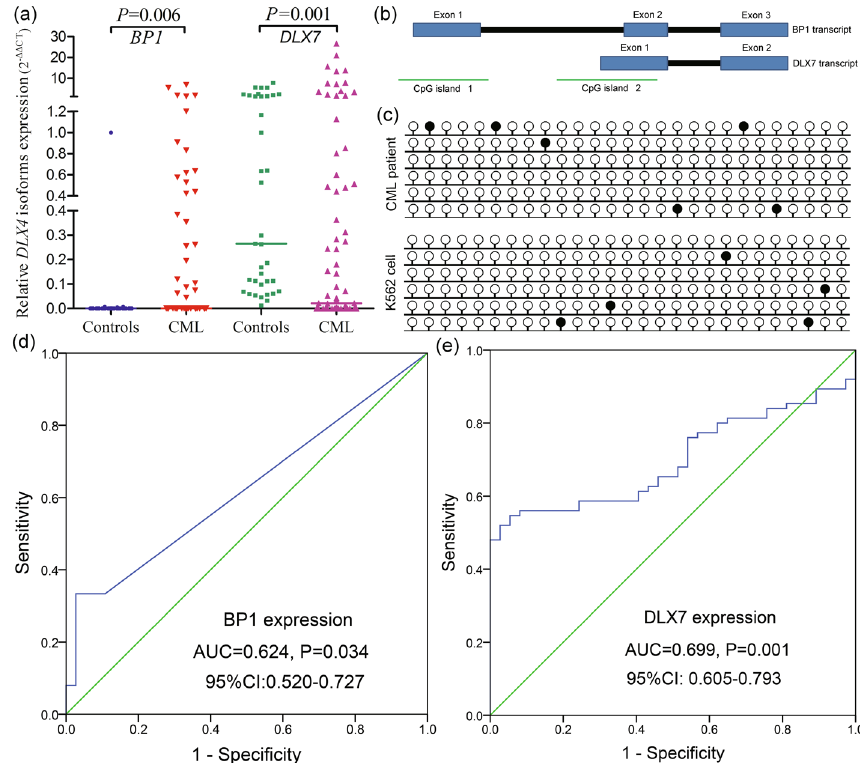
Fig. 1 DNA methylation‑mediated differential expression of DLX4 isoforms together with their clinical significance in CML. a Relative expression of DLX4 isoforms BP1 and DLX7 in CML patients. BP1 expression was significantly increased in CML patients, whereas DLX7 expression was significantly decreased as detected by real‑time quantitative PCR. Relative BP1 / DLX7 expression values were calculated using the equation 2 ∆CT [control − sample ( BP1 / DLX7 )] 2 ∆CT [control − sample ( ABL1 )] . ∆CT reflects the disparity in CT value between control and ÷ target or reference sequences. The bone marrow sample from one normal control that possessed the minimal ∆CT between BP1 / DLX7 and ABL1 transcript was selected as control and defined as 100% expression for BP1 / DLX7 transcript. The median level of BP1 / DLX7 expression in each group is shown by a horizontal line. b The coordinates of CpG islands in DLX4 gene. c Methylation density of BP1 promoter CpG island (CpG island 1) in a representative CML patient and K562 cell. The CpG island located at the promoter region of BP1 (CpG island 1) was almost unmethylated in a representative CML patient and K562 cell as detected by bisulfite sequencing. A white circle indicates unmethylated CpG dinucleotide, whereas a black circle indicates methylated CpG dinucleotide. Each line represents an independent clone‑sequencing result of BSP product of K562 cell or CML patient. d The discriminating value of BP1 in CML patients. BP1 expression may serve as a potential biomarker for distinguishing CML patients from controls with an AUC value of 0.624. e The discriminating value of DLX7 in CML patients. DLX7 expression may serve as a potential biomarker for distinguishing CML patients from controls with an AUC value of